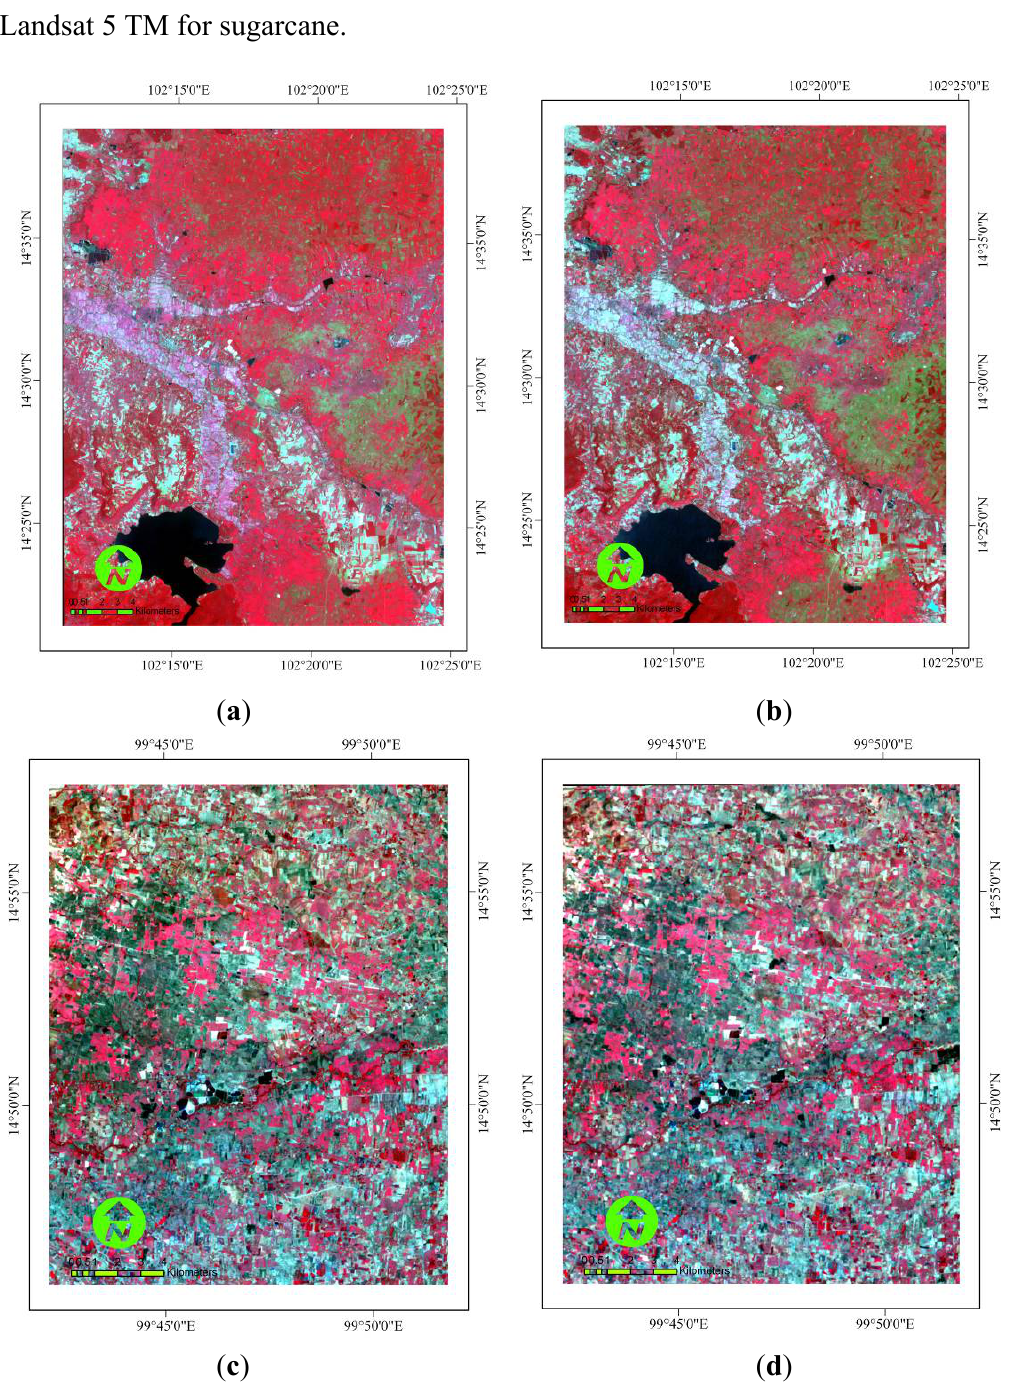
Figure 2. Multispectral images from THEOS and Landsat 5 TM for the study area: ( a ) THEOS for cassava. ( b ) Landsat 5 TM for cassava. ( c ) THEOS for sugarcane. ( d ) Landsat 5 TM for sugarcane.